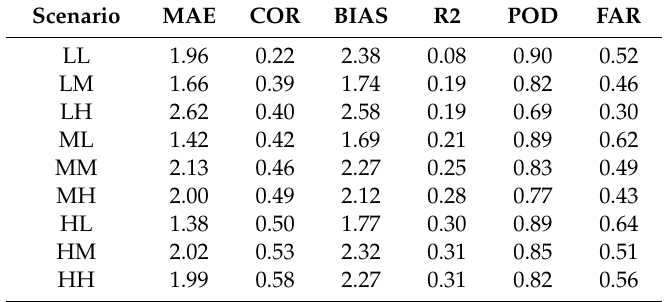
Table 4. Nowcasting skill for di ff erent spatial variability scenarios with a lead time of 1 h. Scenario MAE COR